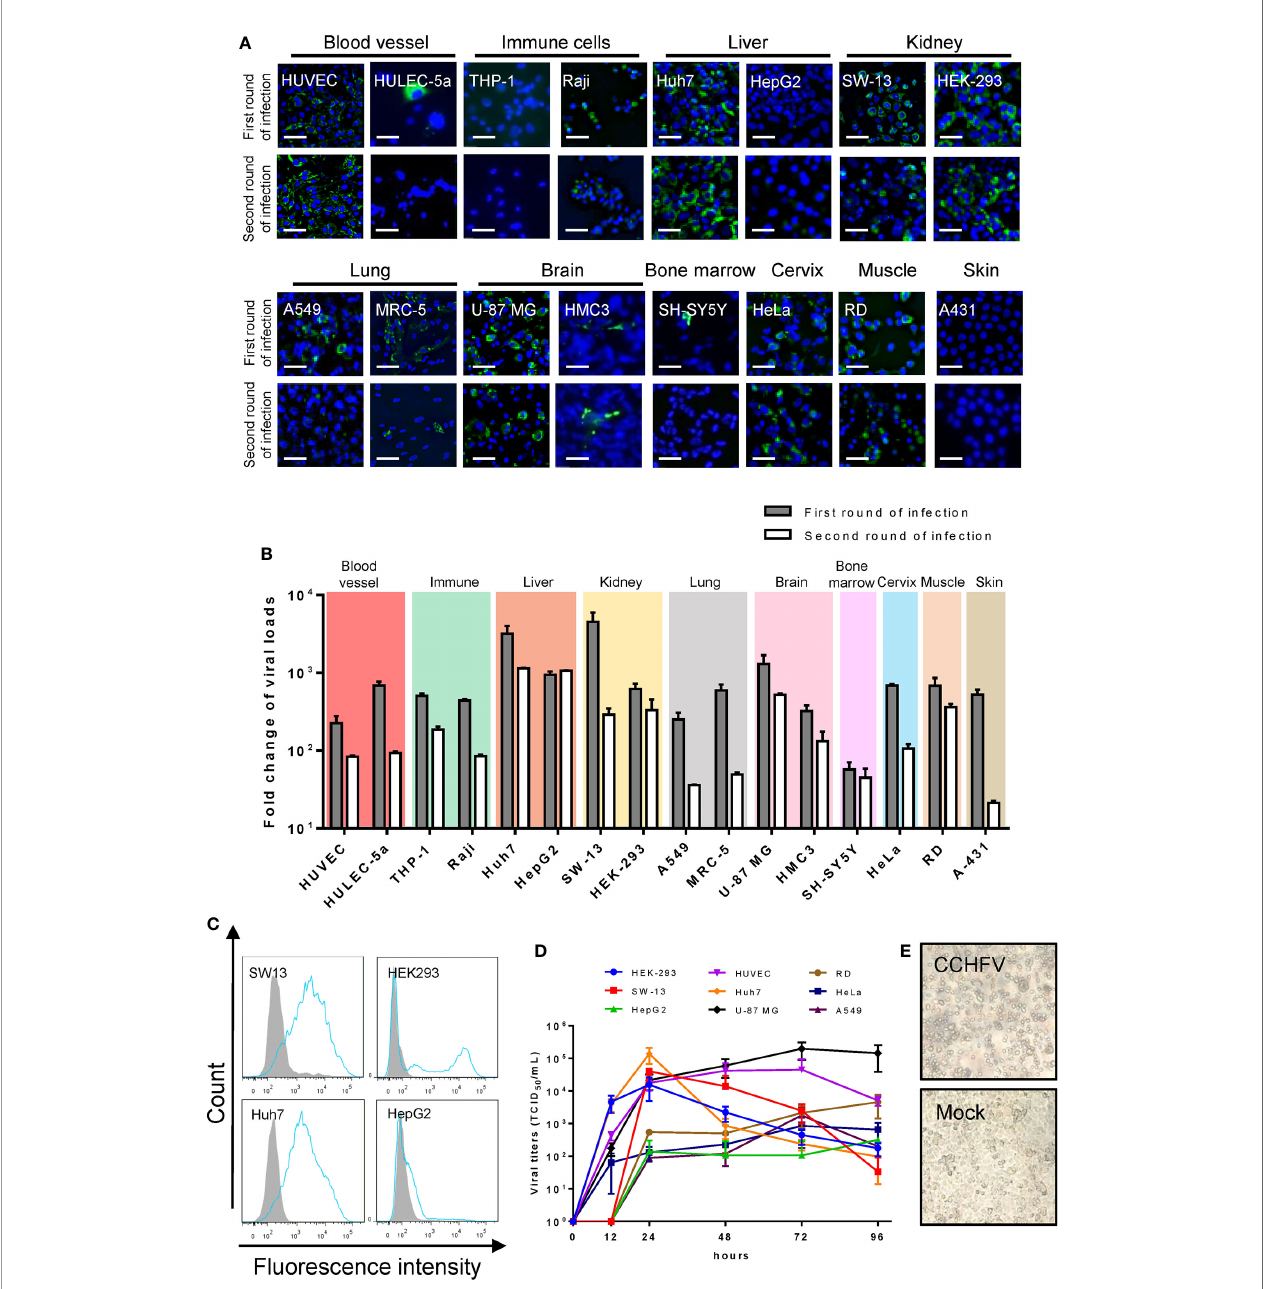
FIGURE 1 | Human cell line susceptibility to CCHFV. (A) Human cell line susceptibility to CCHFV as determined by immuno fl uorescence assay (IFA). Cells were infected with CCHFV at an MOI of 0.01 and CCHFV nucleoprotein (NP) expression was detected at 4 days post-infection (d p.i.) using IFA. Infected cells exhibited green fl uorescence (NP). Bars, 30 m m. (B) Human cell line susceptibility to CCHFV as de fi ned by fold change of viral loads. Various cell lines were infected with CCHFV at an MOI of 0.01. Supernatants were harvested at 4 d p.i. and used for qRT-PCR. All experiments were performed in duplicate. Fold-change of viral loads were normalized to baseline viral load. (C) Flow cytometric analysis of CCHFV-infected cells. Different cell lines were infected with CCHFV at an MOI of 0.01. Cells were harvested at 2 d p.i. and expression of CCHFV NP was detected using fl uorescein isothiocyanate (FITC)-conjugated CCHFV NP monoclonal antibody and analyzed using fl ow cytometry. The shaded area represents the control. The mean fl orescence intensity (MFI) of mock-infected/CCHFV-infected were 837/10200, 44/ 6491, 179/5528 and 375/839 for SW13, HEK293, Huh7 and HepG2 cells respectively. At least 10000 cells were used for analysis. (D) Viral characteristics of CCHFV in 6 human cell lines. The different cell lines were infected with CCHFV at an MOI of 0.01. Supernatants were harvested at the indicated time points post infection. Viral titers in the supernatants were determined using end-point dilution assays. Means ± SD of three represented independent experiments are shown. (E) SW-13 cells were infected with CCHFV at an MOI of 0.01. Cytopathic effects of cell rounding and detachment were evaluated at 4 d p.i. using an inverted microscopy. Mock, uninfected SW-13